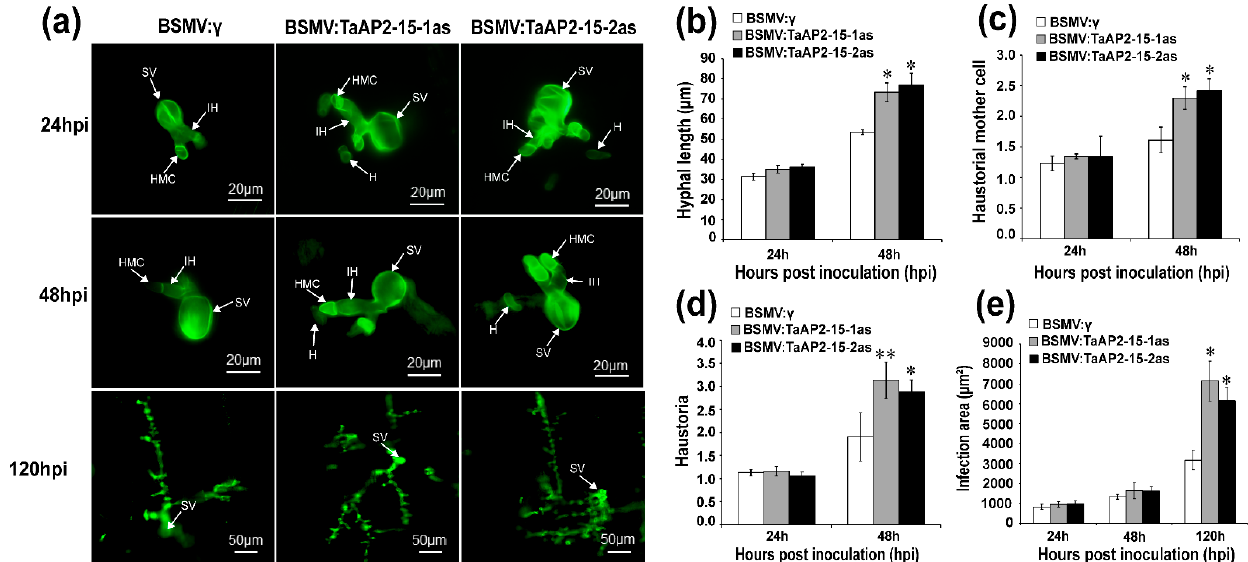
Figure 7. Silencing of TaAP2-15 enhances growth of Pst. ( a ) Fungal structures in knocked-down and control plants challenged with Pst isolate CYR23. Leaves inoculated with Pst were sampled at 24, 48 and 120 hpi. Samples were then stained with WGA (wheat germ agglutinin) for fungal growth detection. Microscopy detection of different structures of Pst was performed by using Olympus BX-51 microscope. SV, sub-stomatal vesicle; IH, infection hypha; HMC, haustorial mother cells; H, haustoria. ( b ) Hyphal length as measured from the juncture of the hypha and substomatal vesicle to the tip of the hypha. DP-BSW tool (Olympus) was used to compute the hyphal length. ( c ) The average number of haustoria mother cells per individual infection site. ( d ) The average number of haustoria per individual infection site. ( e ) The colony area per individual infection point. Data were computed from three biological replications and 50 infection sites. Significant differences between TaAP2-15 -knockdown and control plants were estimated using Student’s t -test and indicated by asterisks. *, p < 0.05, **, p < 0.01.